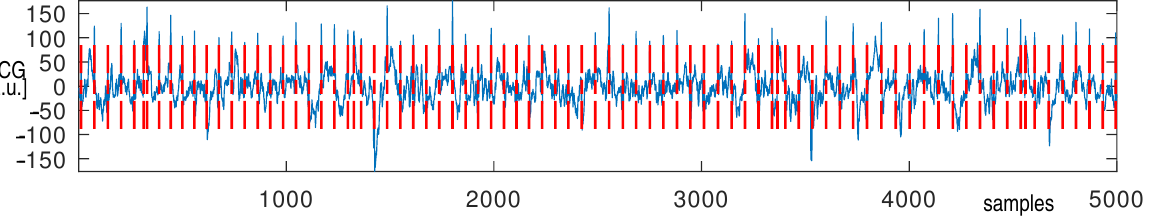
Figure 11. Detection of the R wave in the QRS complex—vertical red lines indicate the positions of the R-wave detected.